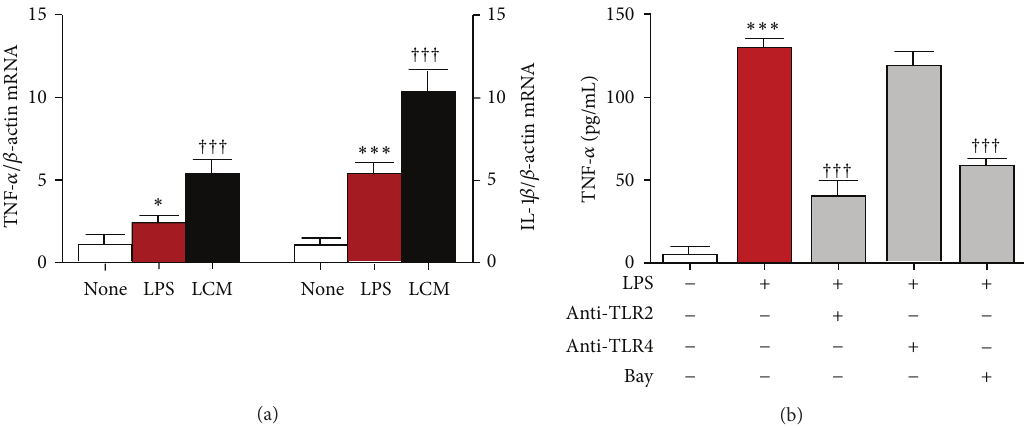
Figure 3: Secretion of proinflammatory mediators by microglia after treatment with the conditioned medium from P.g. LPS-treated leptomeningeal cells and P.g. LPS. The mean mRNA levels of TNF- 𝛼 and IL-1 𝛽 of MG6 microglia at 24 h incubated with P.g. LPS (LPS) and the conditioned medium of leptomeningeal cells (LCM) after treatment with P.g. LPS (a). Data are presented by mean ± SEM ( 𝑛 = 3 ), ∗ 𝑃 < 0.05 , ∗∗∗ 𝑃 < 0.001 versus nontreated cells (none). ††† 𝑃 < 0.001 versus P.g. LPS alone. The P.g. LPS-induced TNF- 𝛼 secretion in MG6 microglia at 48h with the neutralizing antibodies against TLR2 (10 𝜇 g/mL), TLR4 (10 𝜇 g/mL), or Bay 11-7082 (Bay, 20 𝜇 M) (b). Data are presented by mean ± SEM ( 𝑛 = 4 , each), ∗∗∗ 𝑃 < 0.001 versus nontreated cells (none), and ††† 𝑃 < 0.001 versus P.g. LPS